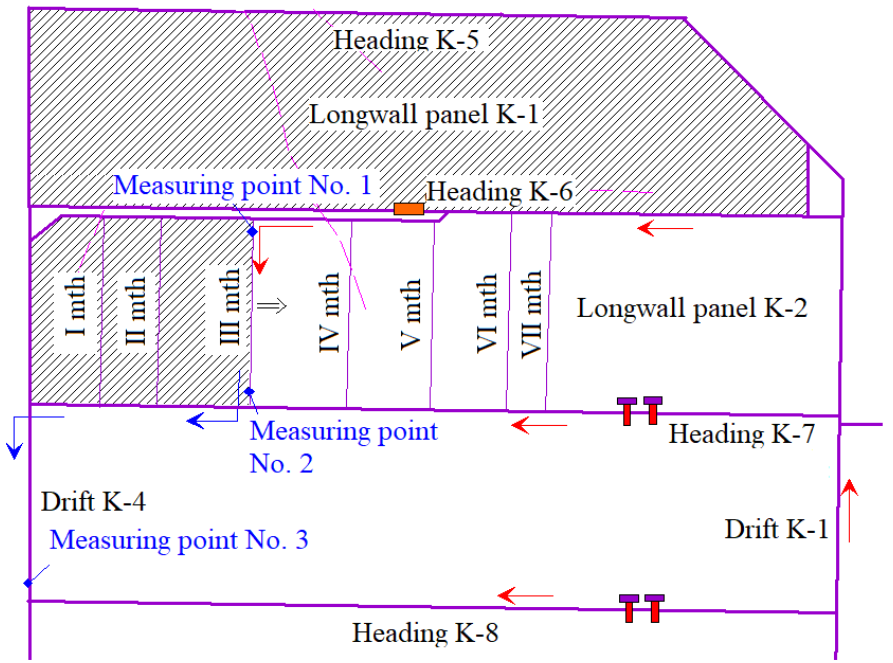
Figure 7. Ventilation diagram of the K-2 longwall environment in the 362/3 + 363 coal seam (red arrow—fresh air; blue arrow—used air).